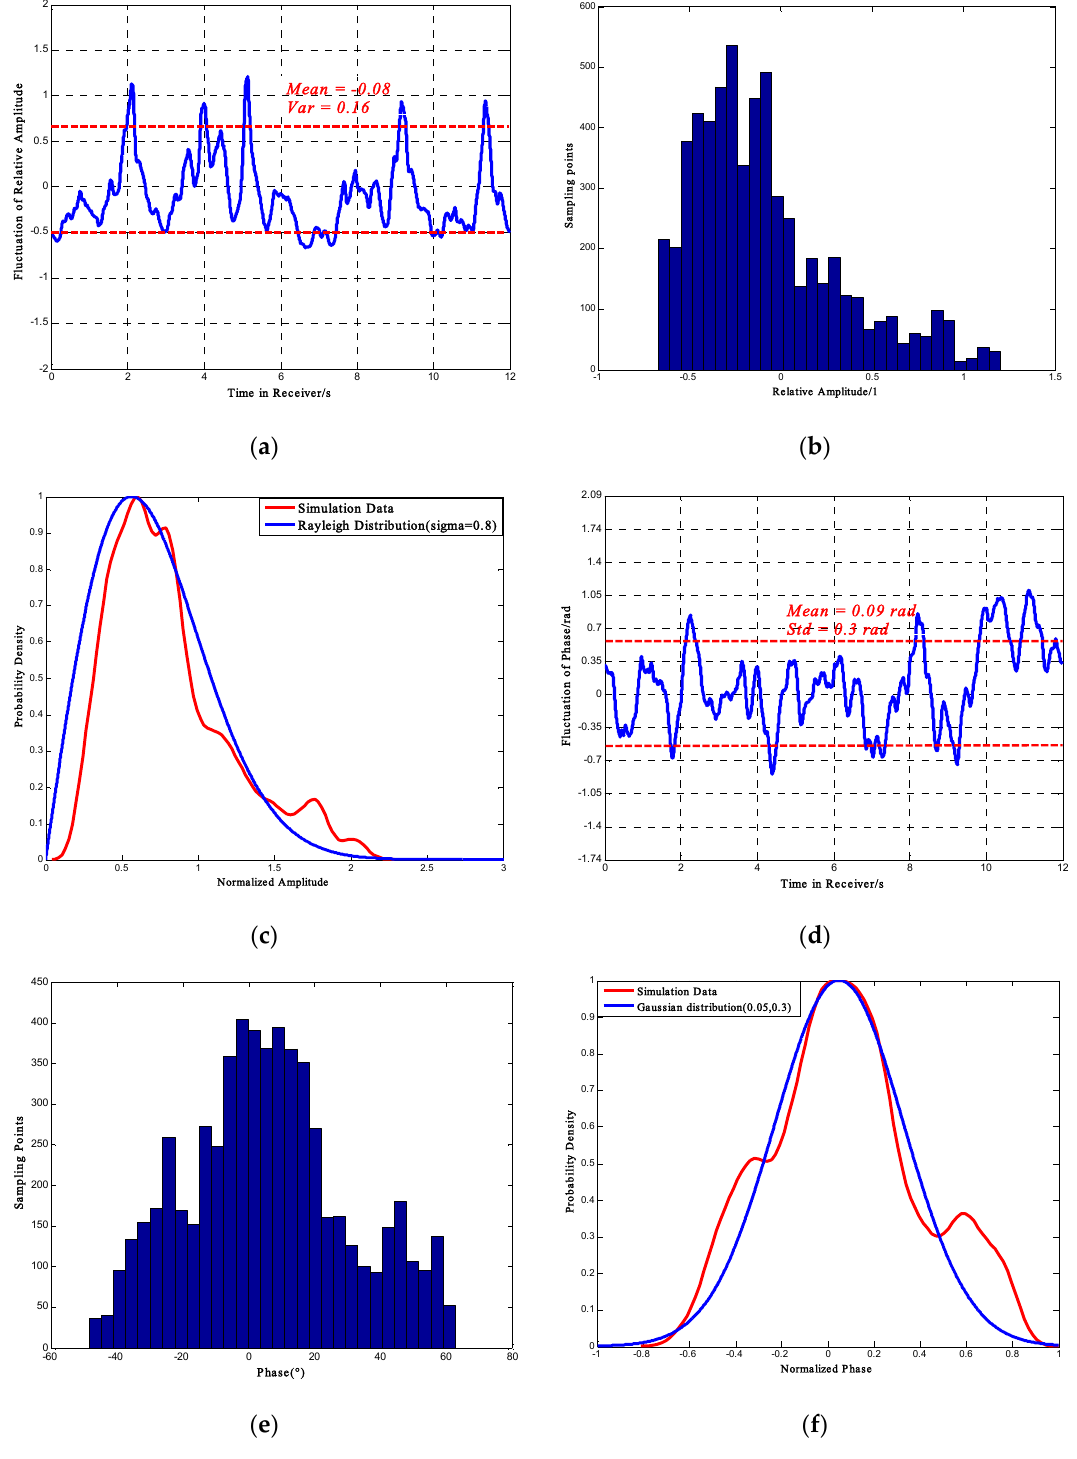
Figure 4. Phase and amplitude for S 4 = 0.47. ( a ) Relative Amplitude Fluctuation; ( b ) Distribution of Amplitude Fluctuation; ( c ) Probability Density Curve; ( d ) Phase Fluctuation; ( e ) Distribution of Phase Fluctuation; ( f ) Probability Density Curve.